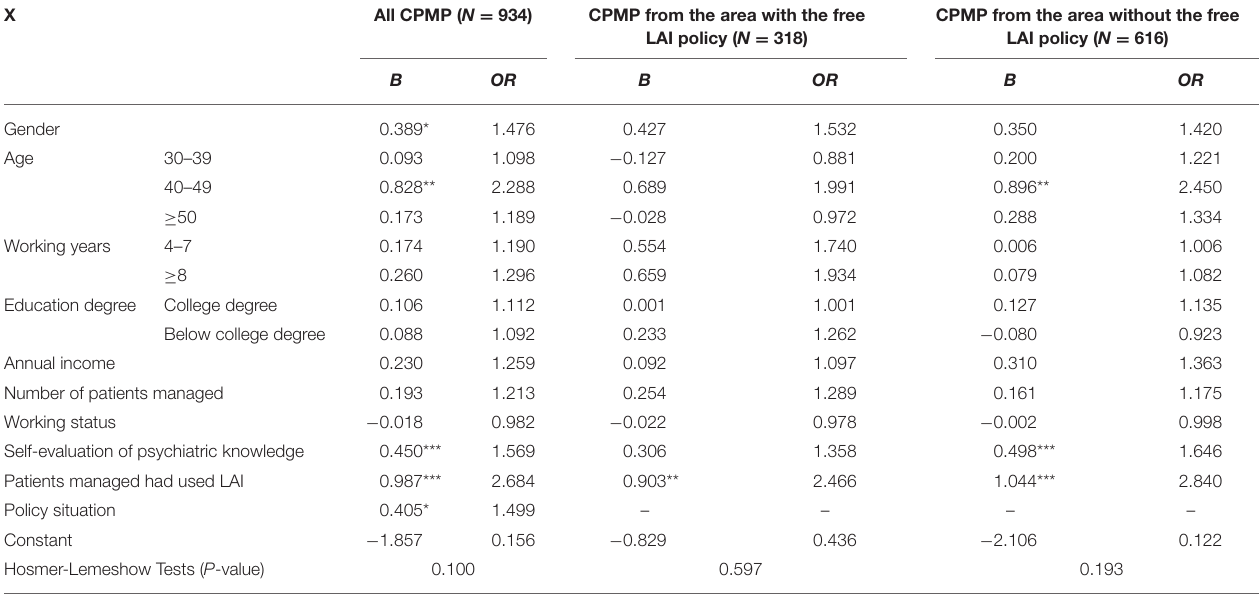
TABLE 3 | Binary regression analysis of factors influencing the willingness of CPMP to recommend LAI preferentially when they come from areas with or without the free LAI policy. X All CPMP ( N = 934) CPMP from the area with the free